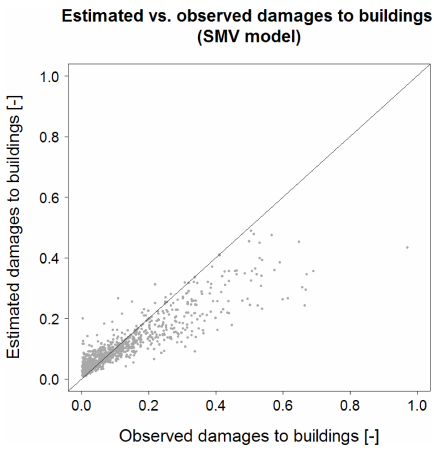
Figure 8. Relative damages to buildings estimated with SMV.